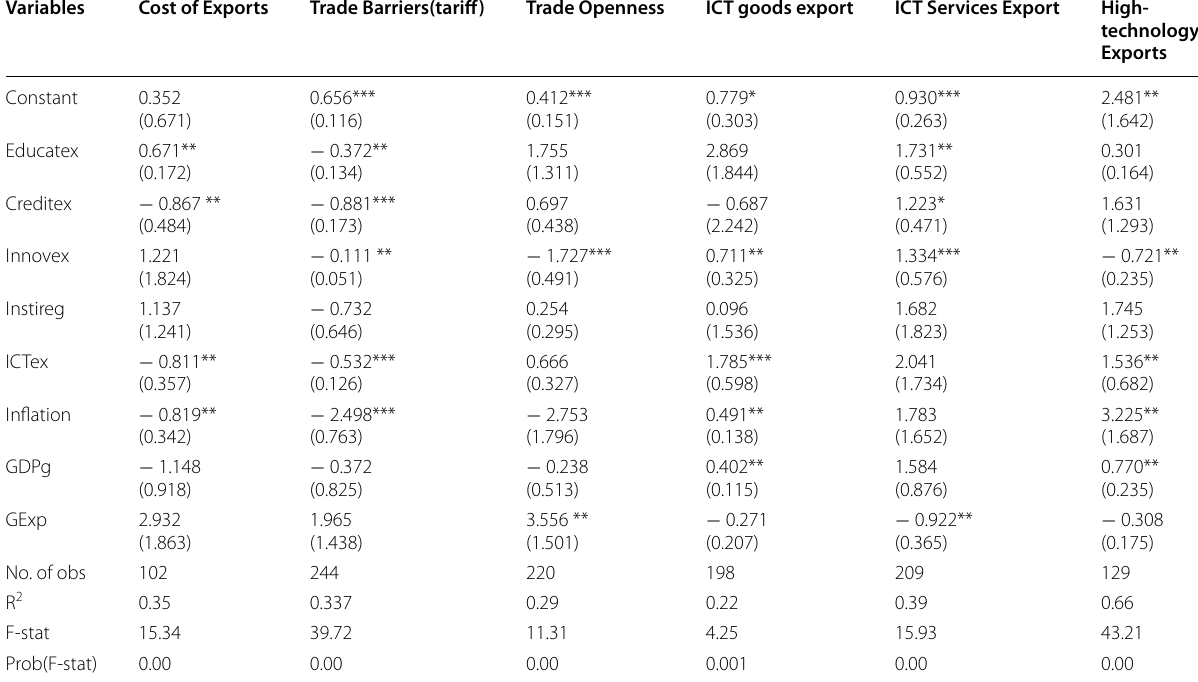
The estimated coefficients are given in the table followed by the standard errors in parenthesis. ***, **, * indicates the level of significance at the 1%, 5%, and 10%, respectively